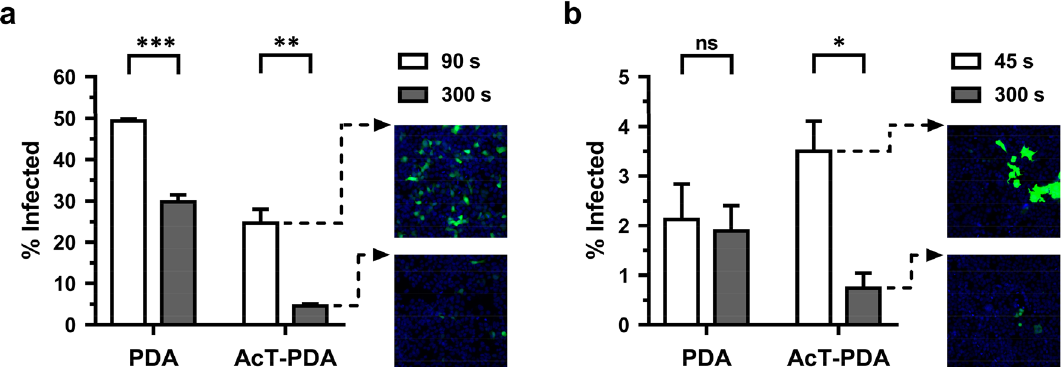
Figure 5. Antiviral activity of AcT (10 μg mL −1 )-PDA composite against different viruses. ( a ) VSVg pseudotyped lentivirus and ( b ) SARS-CoV-2 pseudovirus in 300 s at 25 °C. The x-axis shows the condition tested and the y-axis shows the % infected. The black bars represent t = 90 s and t = 45 s for the lentivirus and pseudovirus, respectively, while the gray bars represent t = 300 s. The representative images show the virus-infected cells after treatment with AcT-PDA at initial time point (t = 90 s for lentivirus and t = 45 s for pseudovirus) and at 300 s. Nuclei are stained blue with Hoechst 33342. A student’s t-test was used to calculate statistical significance. Error bars represent mean ± SEM across three replicates. *p < 0.05, **p < 0.01, ns-not